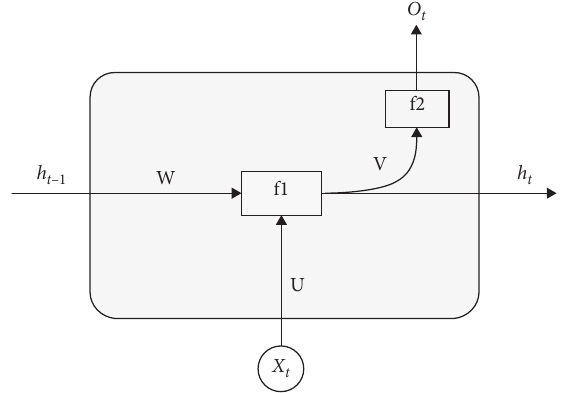
Figure 1: Basic structure of the RNN hidden